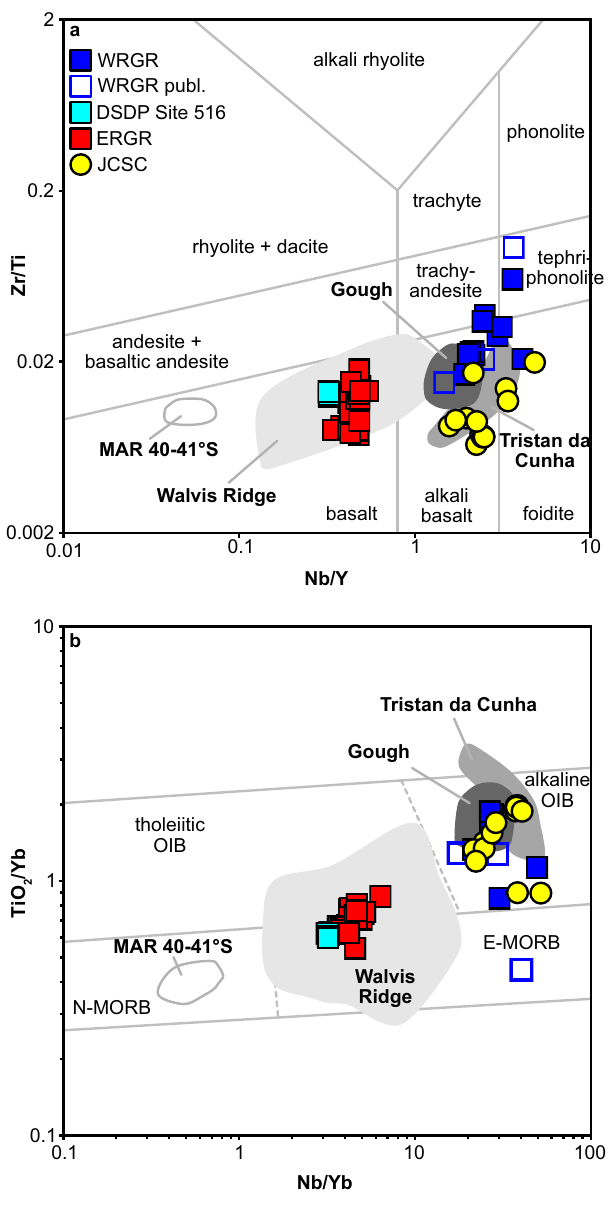
Fig. 2 Classi fi cation diagrams using fl uid-immobile trace element ratios. a Nb/Y versus Zr/Ti discrimination diagram showing that the lavas of the Eastern Rio Grande Rise (ERGR) are relatively homogenous in composition and overlap with those from Deep Sea Drilling Program (DSDP) Site 516 and the Walvis Ridge 15,52 . In comparison, the alkaline samples of the Western Rio Grande Rise (WRGR) exhibit a wider geochemical variety and overlap with previously dredged alkaline rocks from the same area 18,20 , the Jean Charcot Seamount Chain (JCSC) and those from the ocean islands of Tristan da Cunha and Gough 53 – 56 . b Nb/ Yb and TiO 2 /Yb discrimination diagram showing that the samples from the ERGR and those from the Walvis Ridge 15,52 and DSDP Site 516 follow a diagonal trend from the alkaline Ocean Island Basalt (OIB) fi eld to the tholeiitic normal Mid-Ocean Ridge Basalt (N-MORB) fi eld indicating plume – ridge interaction during their formation. In contrast, the alkaline lavas from the WRGR, the JCSC as well as those from present-day ocean islands plot with the alkaline OIB fi eld. For comparison data from South Atlantic MORB 57 glass from 40 to 41°S are shown. Note, to minimize the effects of fractional crystallization processes, we only show samples with MgO ≥ 4 wt.%. Modi fi ed after Pearce 29,30 .